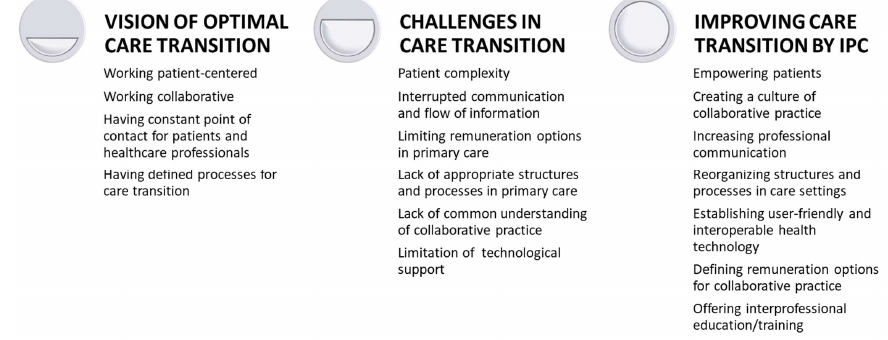
Figure 1. Summary of the main and sub-theme system .